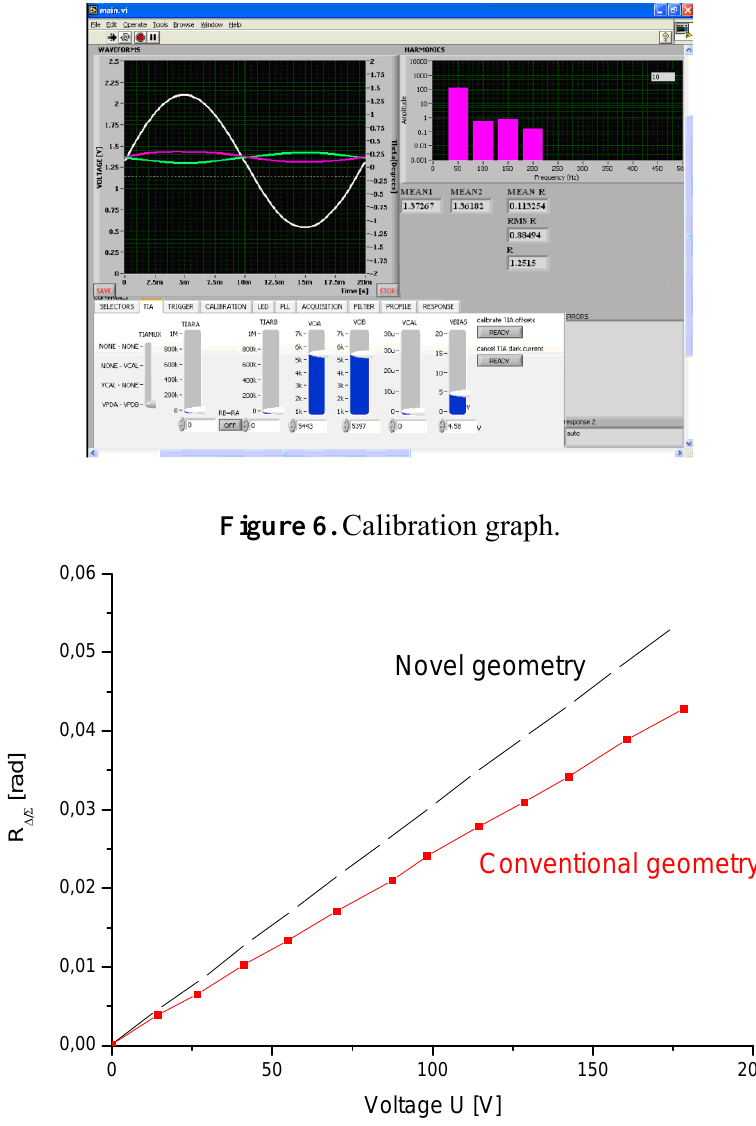
Figure 5. Measurement screen for excitation voltage of 71.5 V.